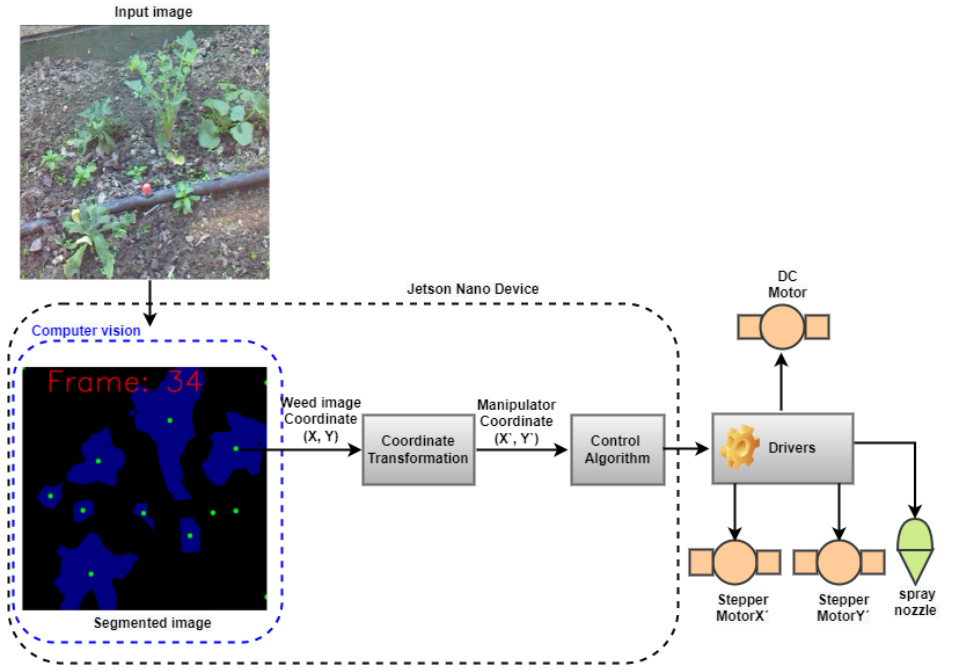
Figure 8. General view of the practical